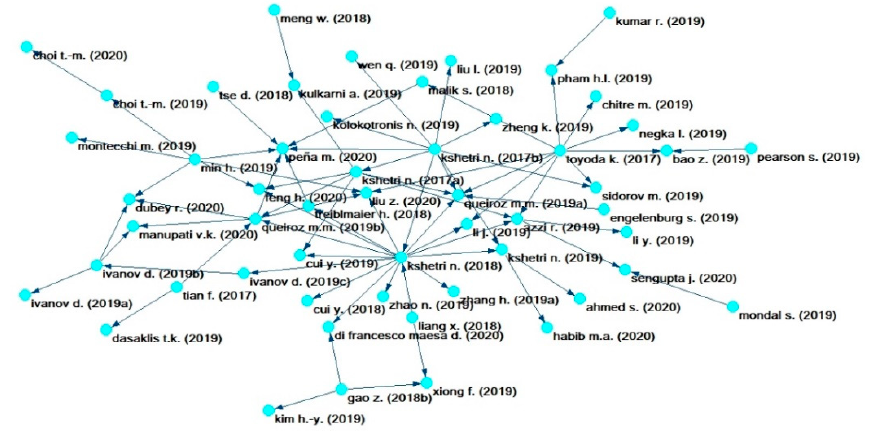
Figure 4. Main connected components of the citation network.